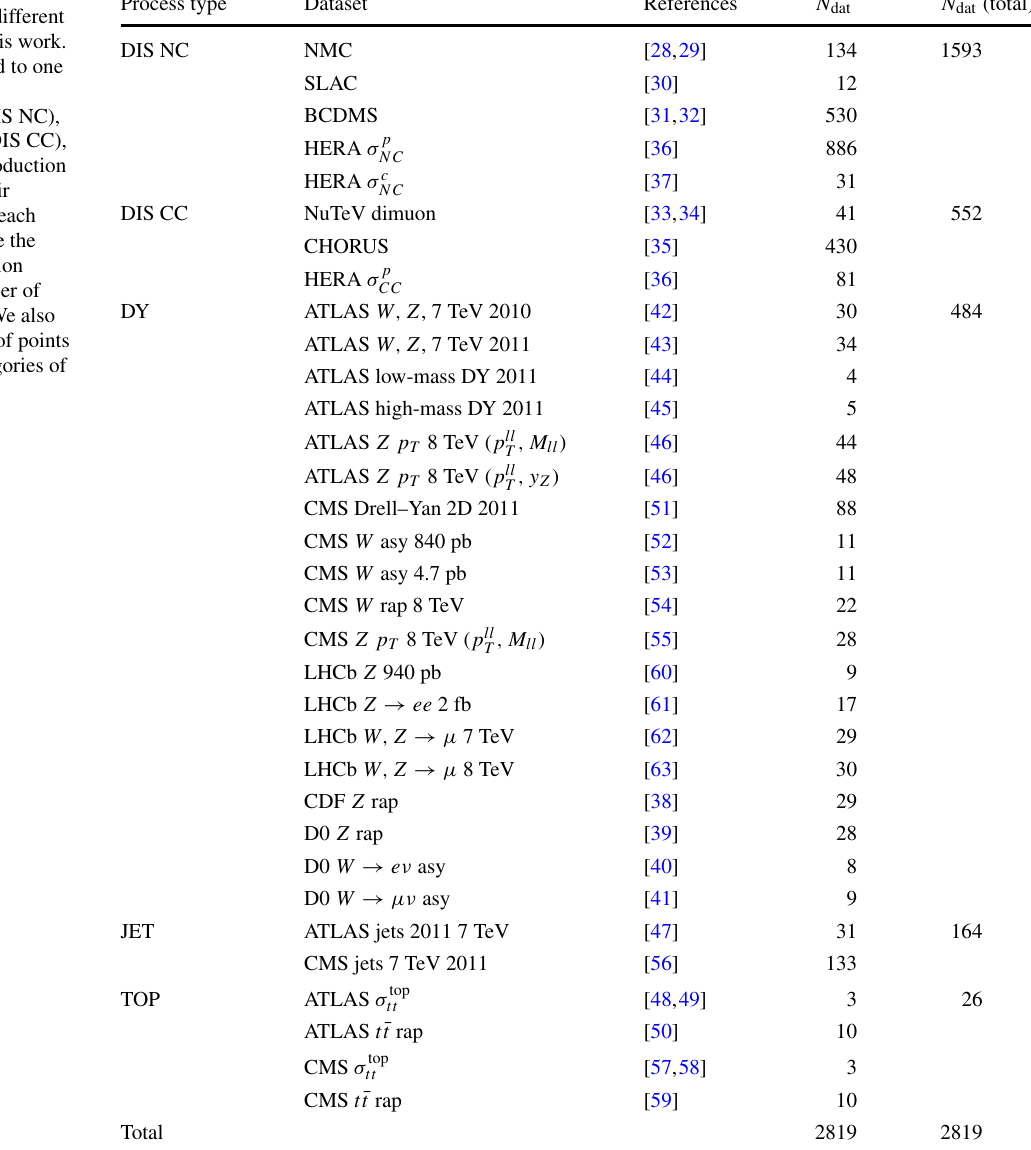
Table 2 The categorization of the input datasets into different processes adopted in this work. Each dataset is assigned to one of five categories: neutral-current DIS (DIS NC), charged-current DIS (DIS CC), Drell–Yan (DY), jet production (JET) and top quark pair production (TOP). For each dataset, we also provide the corresponding publication reference and the number of data points after cuts. We also show the total number of points in each of the five categories of